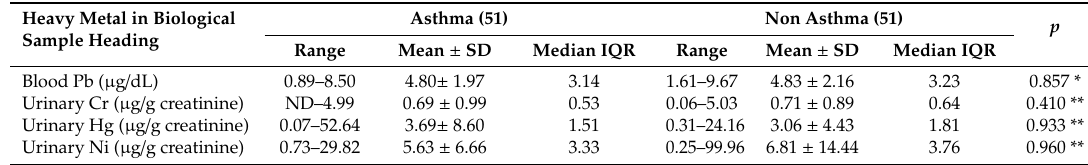
Table 5. Average concentrations of blood lead (Pb) and urinary mercury (Hg), nickel (Ni), and chromium (Cr) in study subjects stratified by asthma